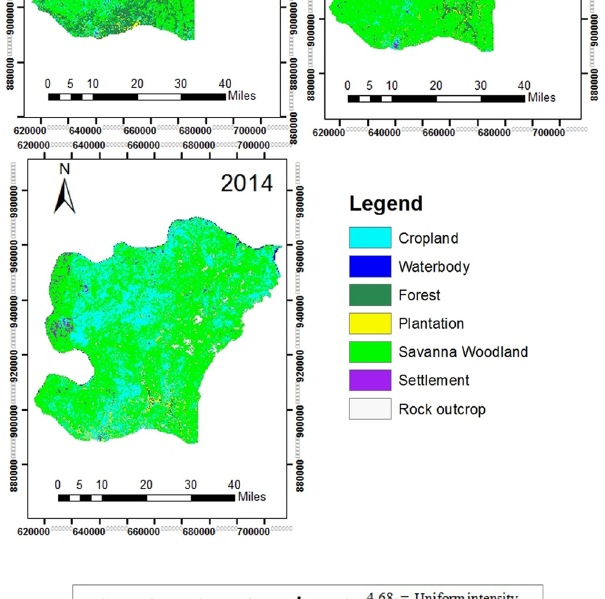
Figure 2. LULC maps of 1986, 2001 and 2014